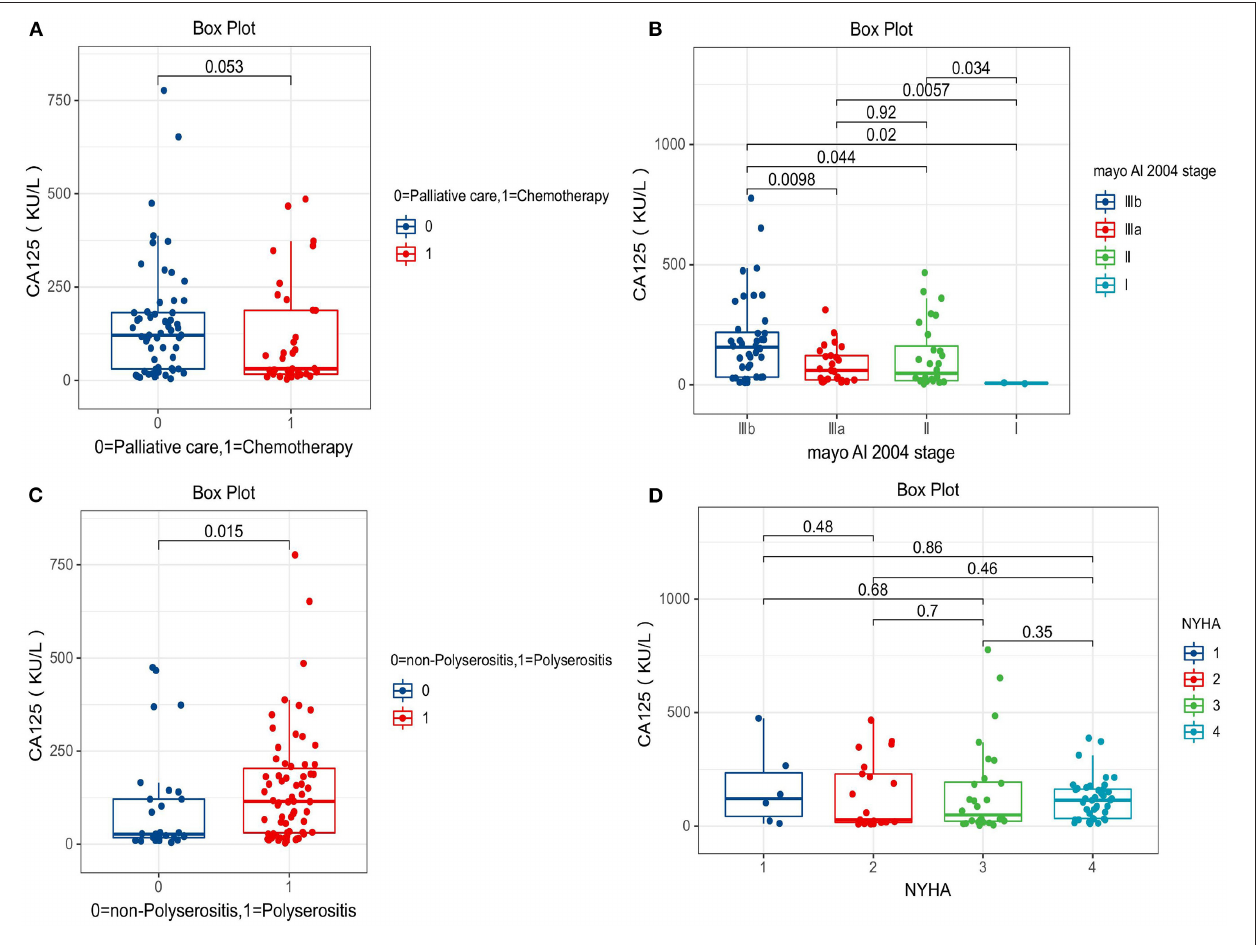
FIGURE 2 | Comparison of serum carbohydrate antigen 125 (CA 125) levels between different groups. (A) Palliative care group vs. chemotherapy group (150.8 ± 153.7 vs. 109.9 ± 138.7). (B) Mayo AL 2004 stage I (6.5 ± 2.6), II (117.1 ± 134.4), IIIa (84.4 ± 77.7), IIIb (185.3 ± 178.0). (C) Polyserositis group vs. non-Polyserositis group (150.2 ± 150.6 vs. 100.0 ± 140.4). (D) NHYA I (169.6 ± 175.6), II (134.2 ± 151.5), III (150.6 ± 202.5), IV (119.1 ±